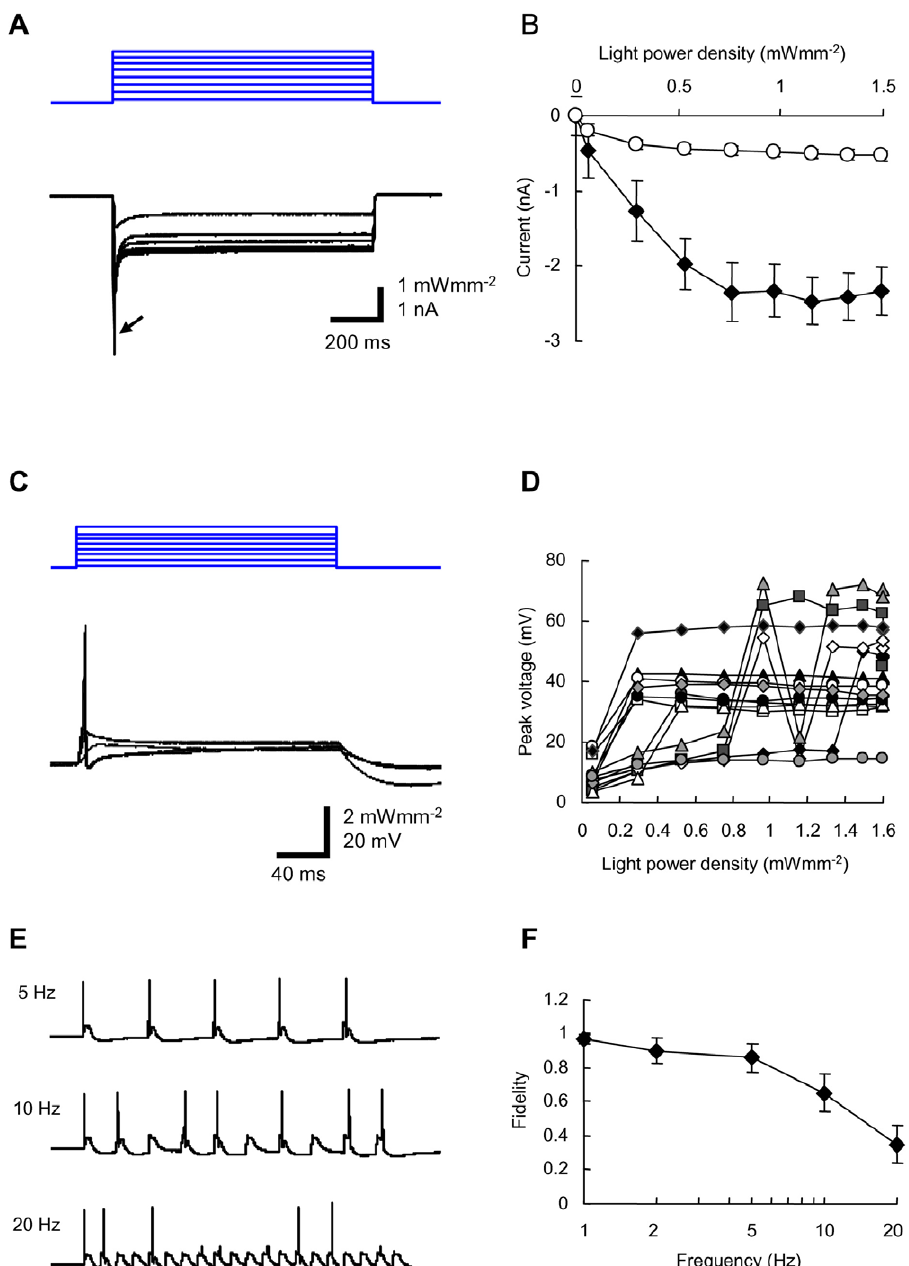
Figure 5. Optical responses of the ChR2V + DRG neurons. A. Representative records of photocurrents (bottom) evoked by blue LED light of variable strength (top) under voltage clamp. An arrow indicates the unclamped current from escaped action potentials. B. The peak (closed diamonds) and the steady-state (open squares) photocurrent amplitudes (mean 6 SEM, both n=24) as functions of the light power density. C. Representative records of the neuronal membrane potential evoked by blue LED pulses (200 ms) of variable strength under current clamp. The resting membrane potential, 2 56 mV. D. The maximal voltage changes as a function of the light power density (n=16). E. Representative records of membrane potential responses of a ChR2V-expressing DRG neuron to the repeated flashing of blue LED pulses (1.6 mWmm 2 2 , 20 ms duration) at various frequencies, that is, 5 Hz (top), 10 Hz (middle) and 20 Hz (bottom). F. Fidelity of generation of action potentials as a function of frequency (mean 6 SEM, n=14). doi:10.1371/journal.pone.0032699.g005 blue LED flashes clearly and robustly evoked reflexive movements whereas it was 25 6 68% with red light, showing a significant of the paw or toe, whereas the red LED flashes did not (Video S2). difference (P , 0.05, Wilcoxon signed-rank test, n = 8 animals). The movements during flashing exposure were scored according Relatively large movements (score, 2–3) were frequently evoked by the blue LED flashes (Figure 6B). There was a significant to their magnitudes (Table 1). The proportion of cases when movement occurred during flashing with blue light was 100%, difference between blue and red flashes (n= 8, P , 0.01, Wilcoxon